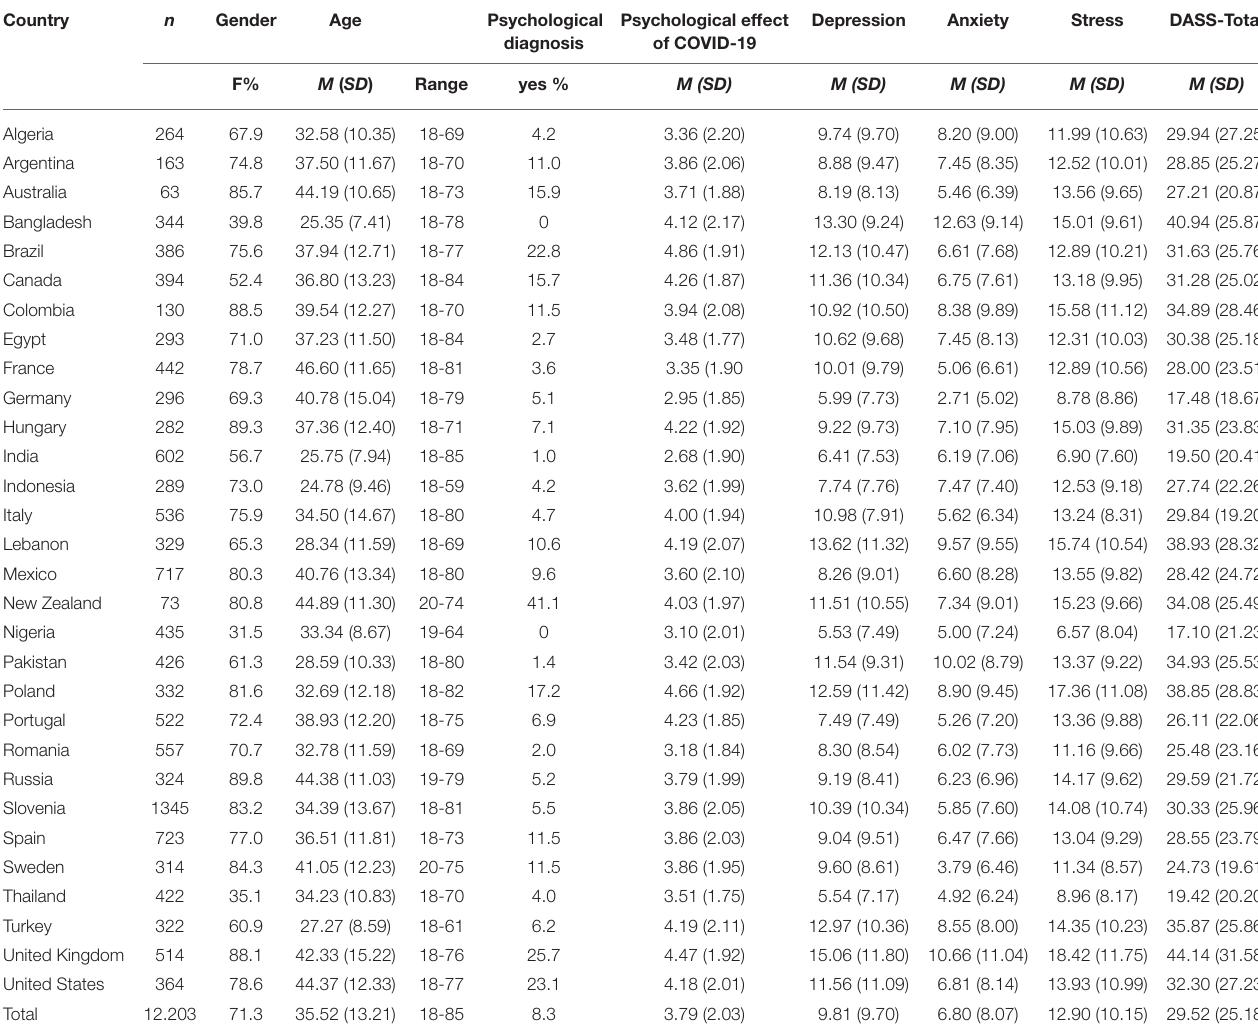
TABLE 1 | Socio-demographic characteristics of the sample and markers of psychological problems. Country n Gender Age Psychological